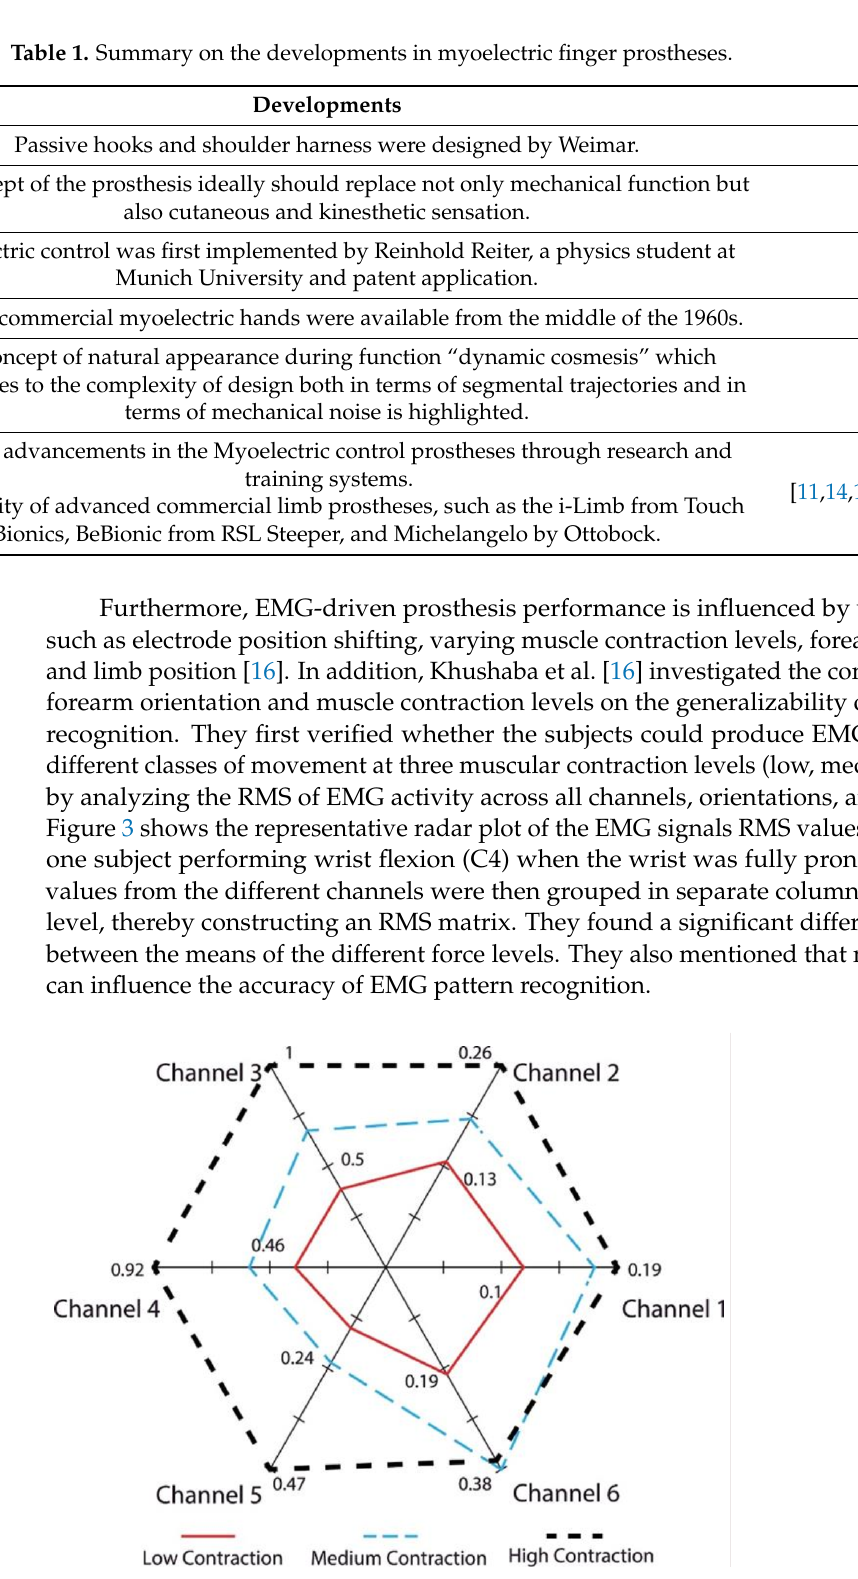
Figure 3. The results of root mean square (RMS) of the electromyogram (EMG) signals from six channels through flexion of the wrist at three different levels